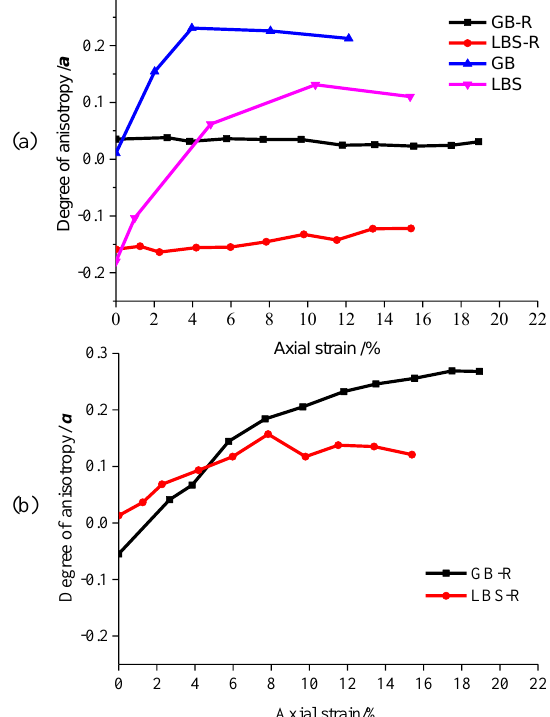
Fig.4 Anisotropy degree 𝑎 of (a) sand-sand contacts and (b) sand-rubber